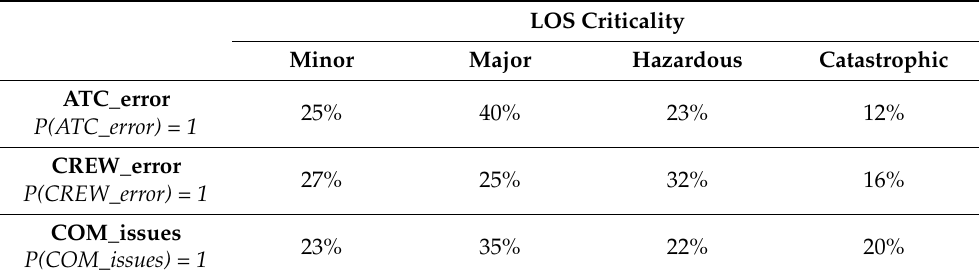
Table 9. LOS Criticality probabilities related to human factors and COM_issues.